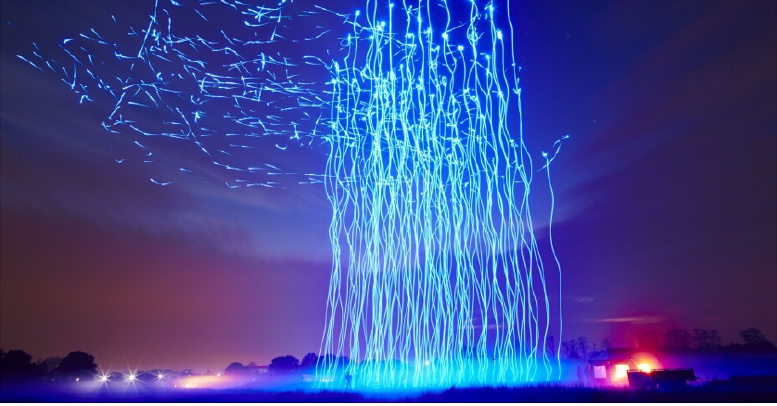
Figure 1. Drone swarm art performance